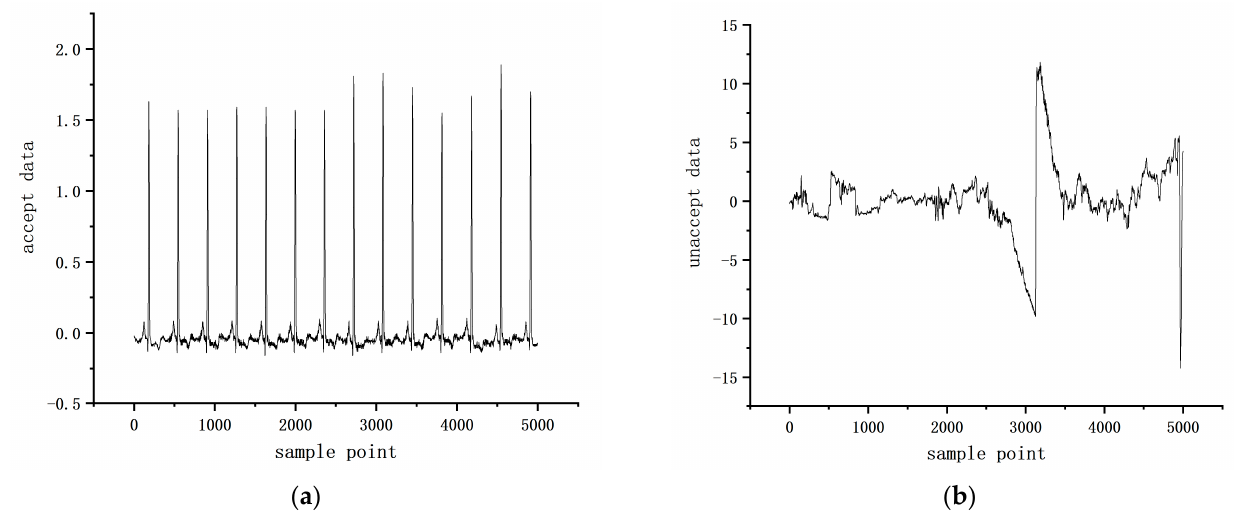
Figure 8. ( a ) An acceptable sample plot corresponds to ( a ) in Figure 7; ( b ) an unacceptable sample plot corresponds to ( b ) in Figure 7.